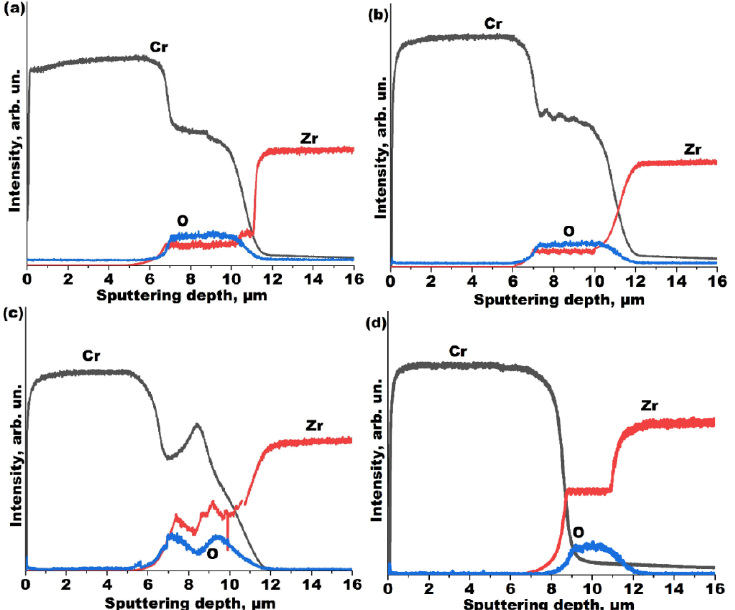
Figure 2. The elemental (Cr, Zr, and O) depth distributions in the ( a ) ZrO 2 /Cr-100, ( b ) ZrO 2 /Cr-250, ( c ) ZrO 2 /Cr-750, and ( d ) ZrO 2 /Cr coatings obtained onto the E110 alloy plates. According to Figures 1 and 2, the ZrO 2 /Cr-250 sample had a 7 µm-thick outer Cr layer and a ZrO 2 /Cr barrier which was between the Cr layer and E110 alloy. This barrier layer was composed of twelve alternate ZrO 2 and Cr multilayers with a multilayer thickness of ~250 nm. The total thickness of the ZrO 2 /Cr-250 coating was 10.2 ± 0.3 µm. The ZrO 2 /Cr- 100 and ZrO 2 /Cr-750 samples had 30 and 4 multilayers with a multilayer thickness of ~100 and 750 nm, respectively. The ZrO 2 /Cr coating had a single-layer ZrO 2 barrier (~1.5 µm)